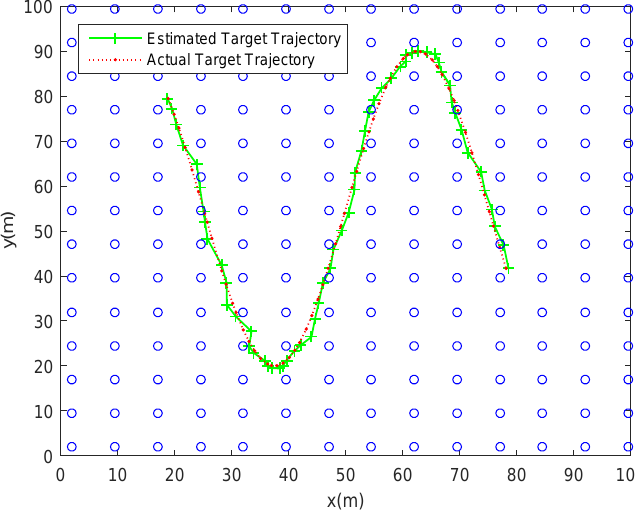
Figure 6. One of tracking trajectories using our proposed tracking scheme in a uniformly distributed sensor network.